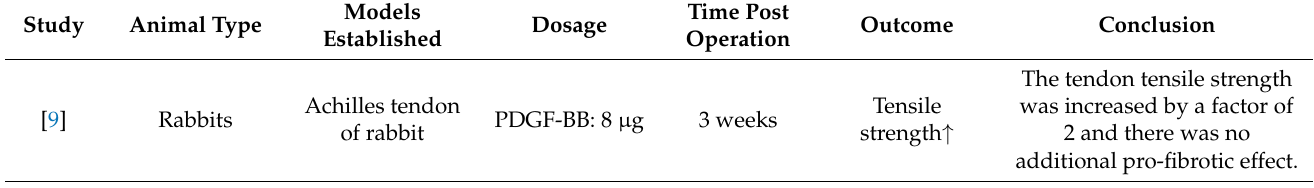
Table 1. The biological responses embodied by PDGF-BB in different animal